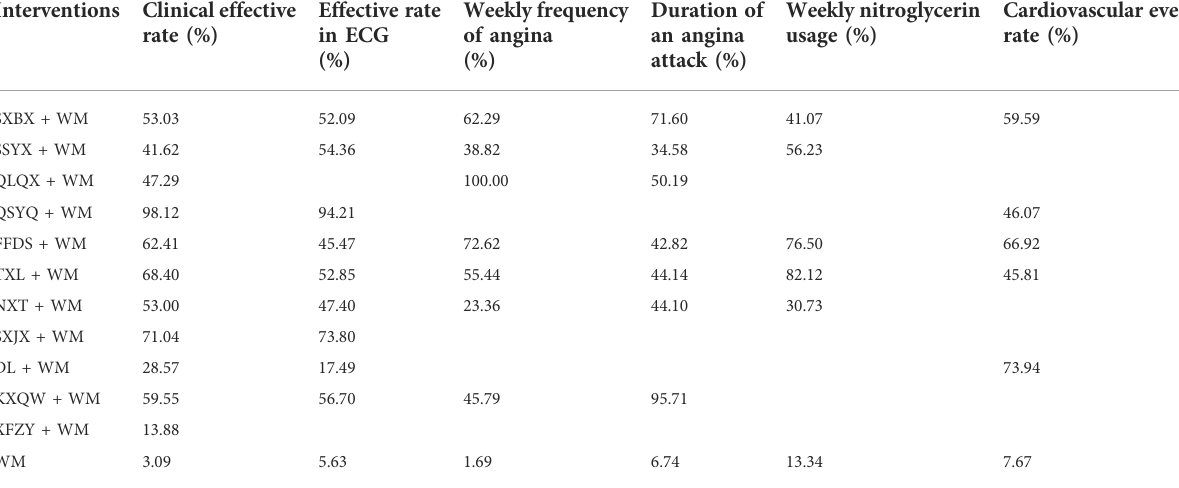
TABLE 1 Ranking probabilities of surface under the cumulative ranking area curves (SUCRA) for the outcomes. Interventions Clinical effective rate